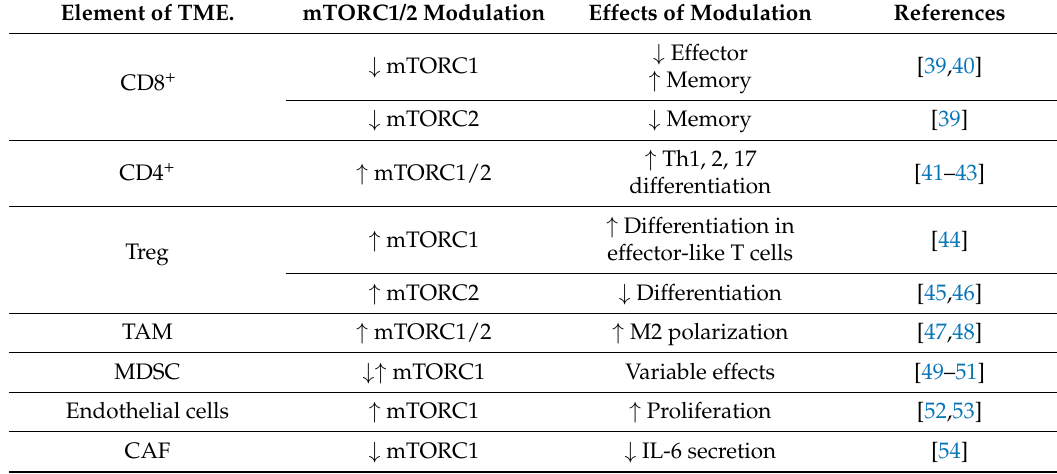
Table 1. Role of mammalian target of rapamycin (mTOR) complexes in tumor